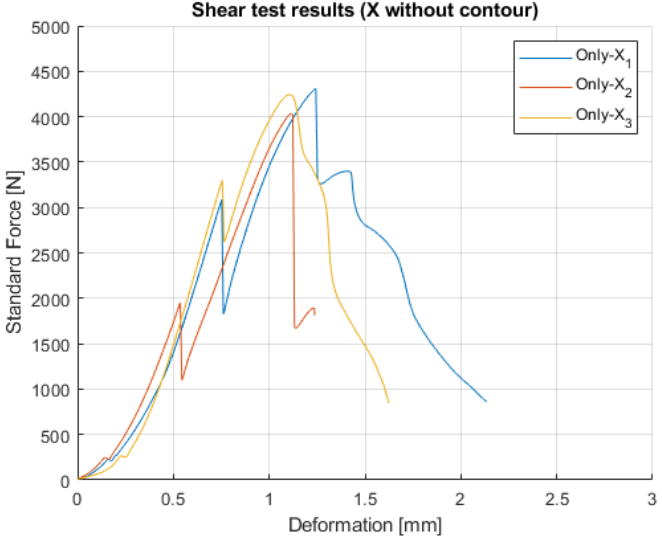
Figure 8. Results of X without contour lines specimens.